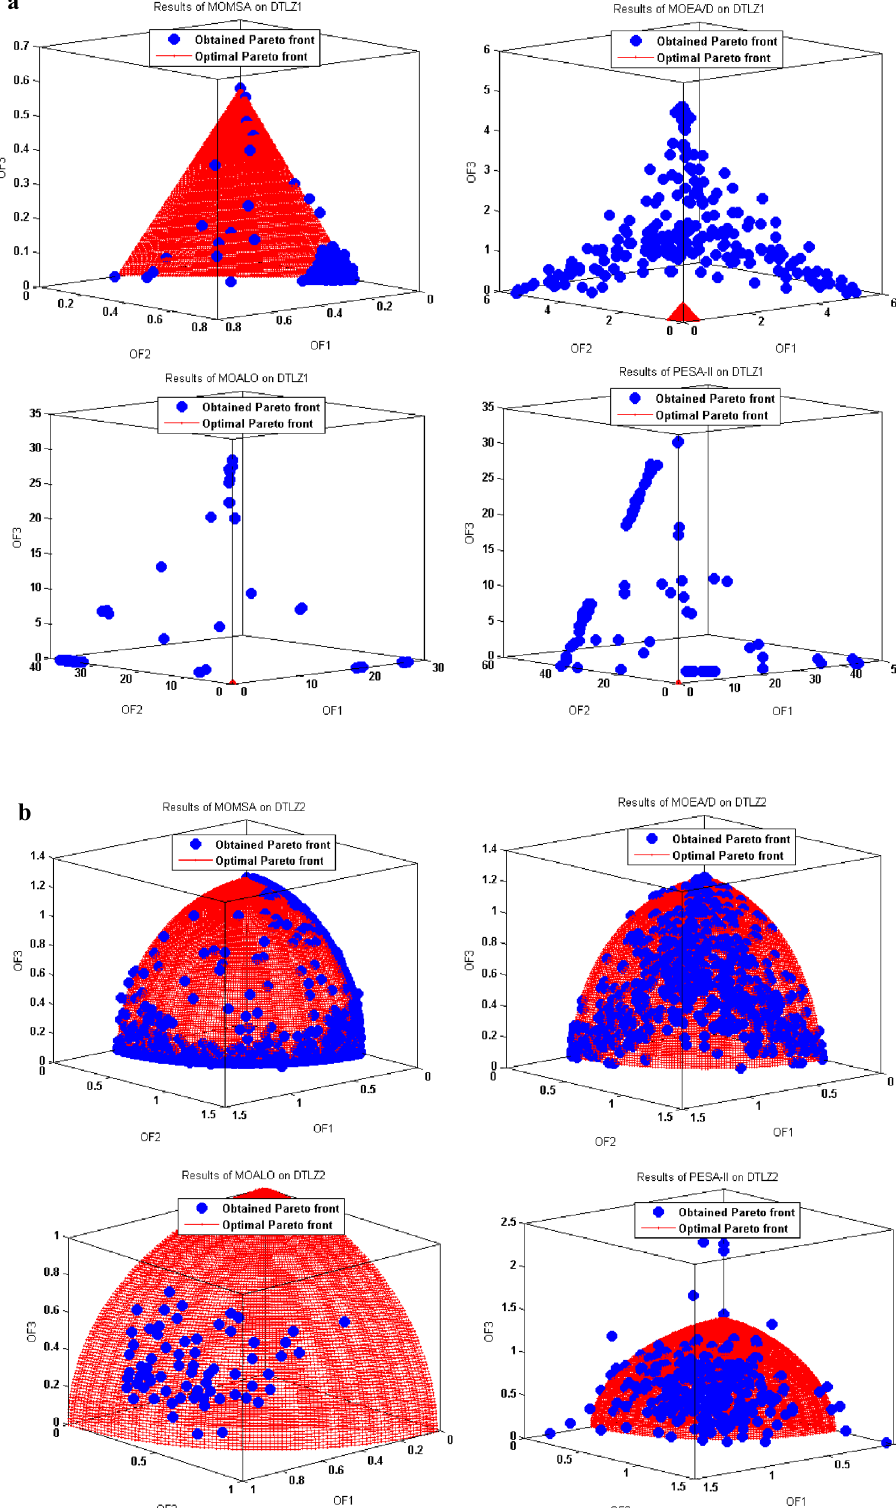
Figure 8. ( a ) Obtained Pareto optimal solutions by MOMSA, MOEA/D, MOALO, and PESA-II for DTLZ1. ( b ) Obtained Pareto optimal solutions by MOMSA, MOEA/D, MOALO, and PESA-II for